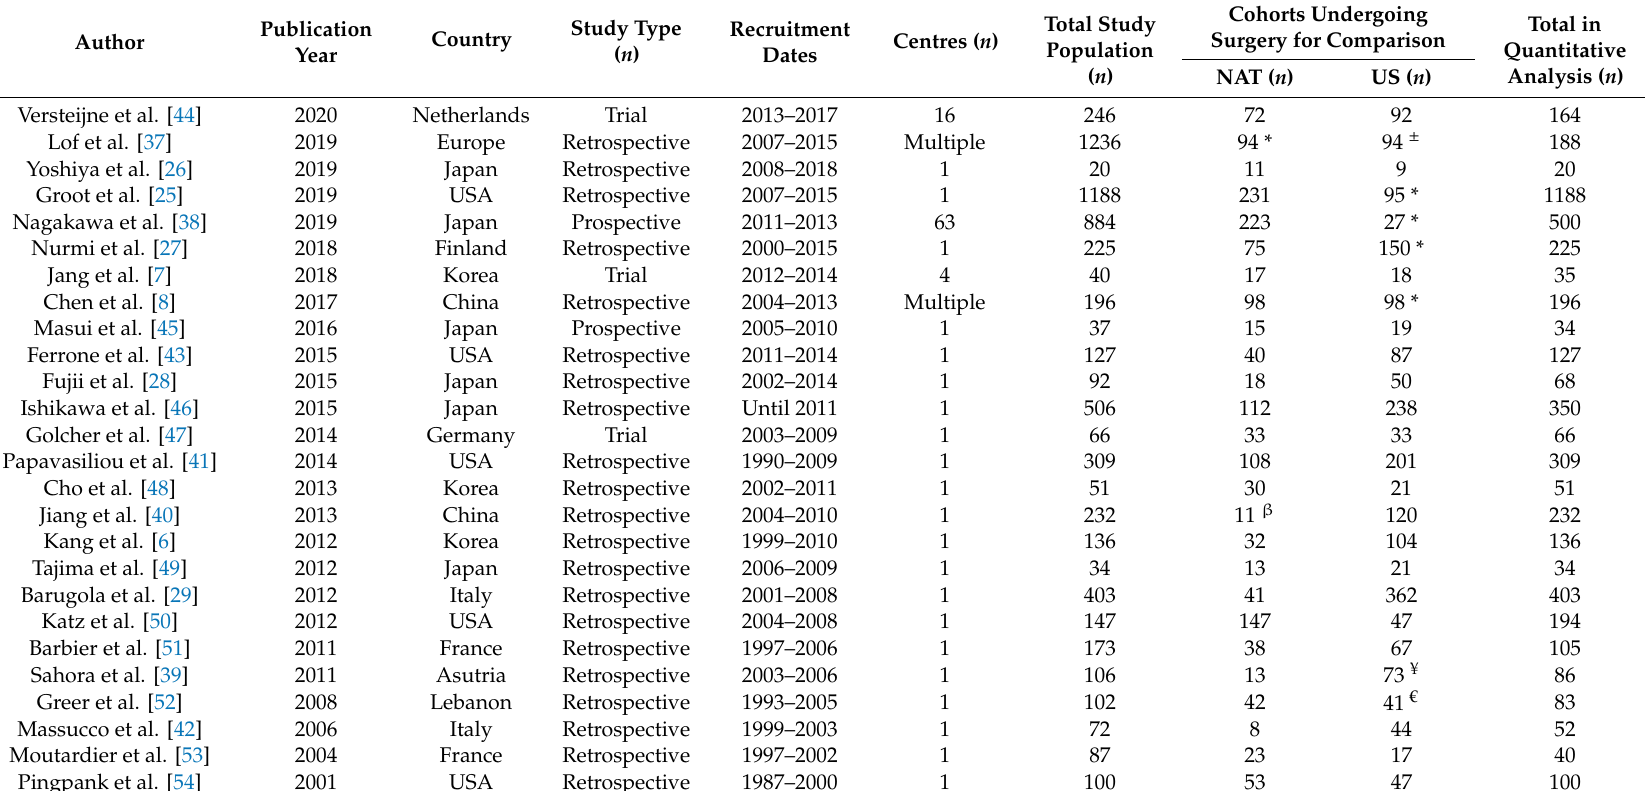
Table 1. Characteristics of all included studies and patients recruited into the meta-analysis for quantitative